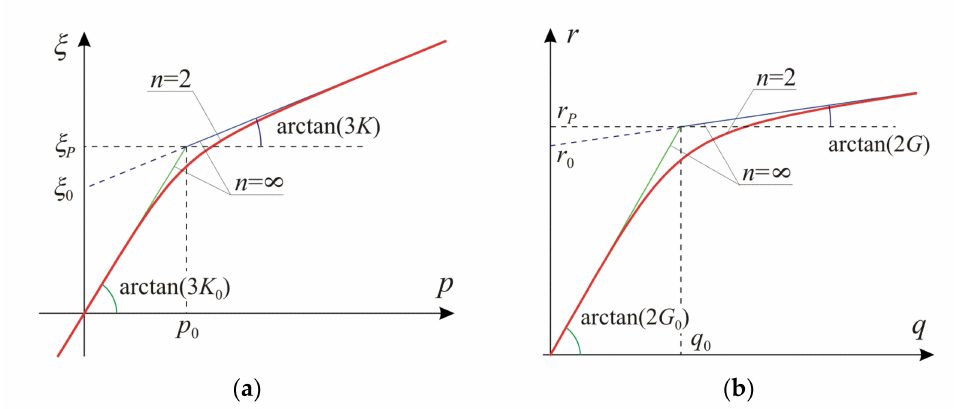
Figure 2. Relationships between stress and strain invariants and asymptotes for K 0 = 4 K , G 0 = 12 G : ( a ) p versus ξ for q = 0; ( b ) q versus r for p = 0. Interpretation of material